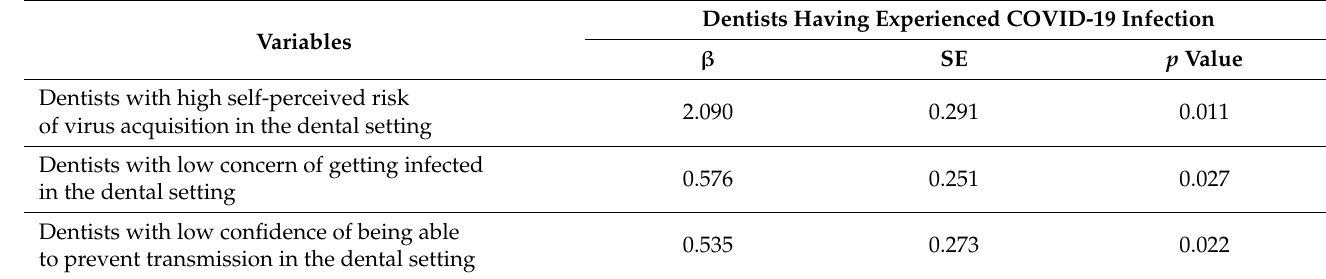
Table 4. Stepwise binary logistic regression of variables associated with COVID-19 infection